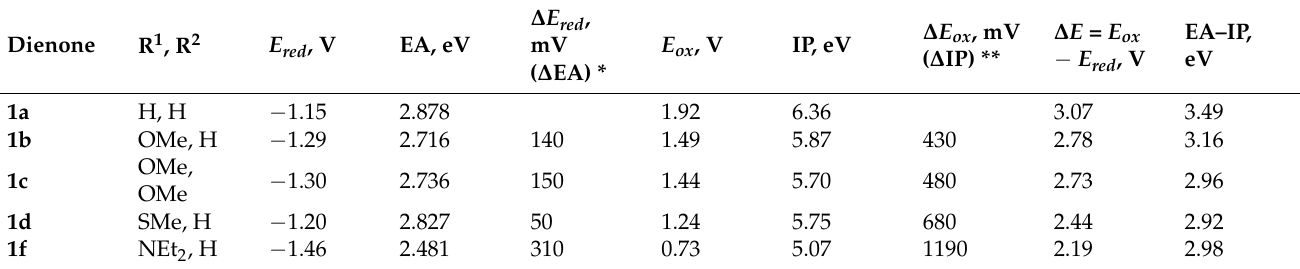
Table 2. Electrochemical potentials of compounds 1a – d , f in MeCN versus Ag/AgCl/KCl(sat.) measured by CV in the presence of 0.1 M Bu 4 NClO 4 on a GC electrode at a potential sweep rate of 100 mV s − 1 .